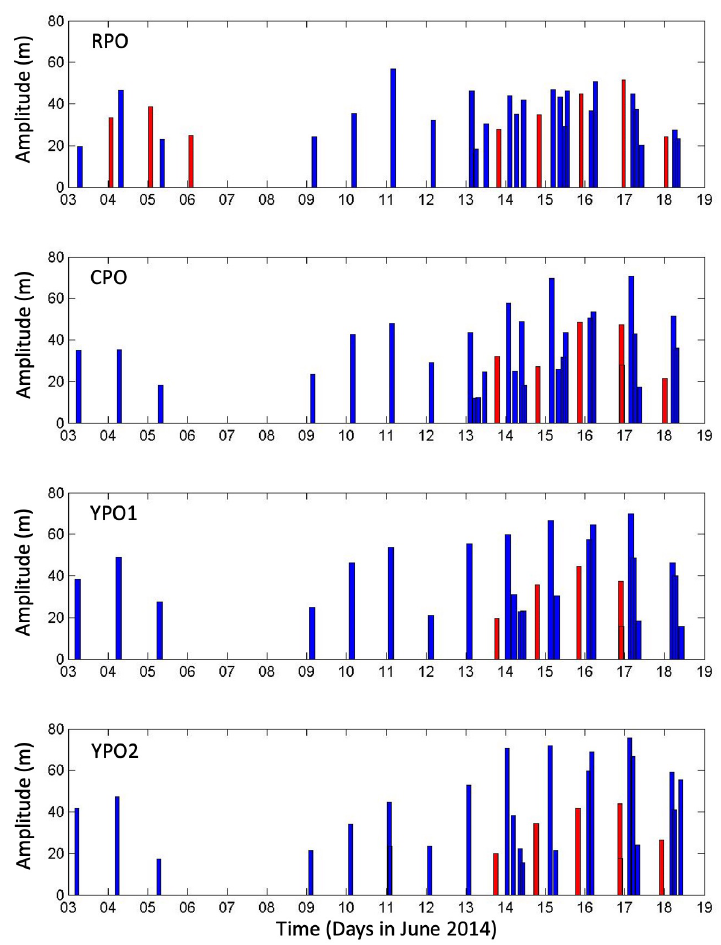
Figure 8. Bar graph of wave amplitudes across the slope. The amplitudes were calculated as deviations of the 20 ◦ C isotherm from its mean position. The a waves are indicated by blue bars and the b waves by the